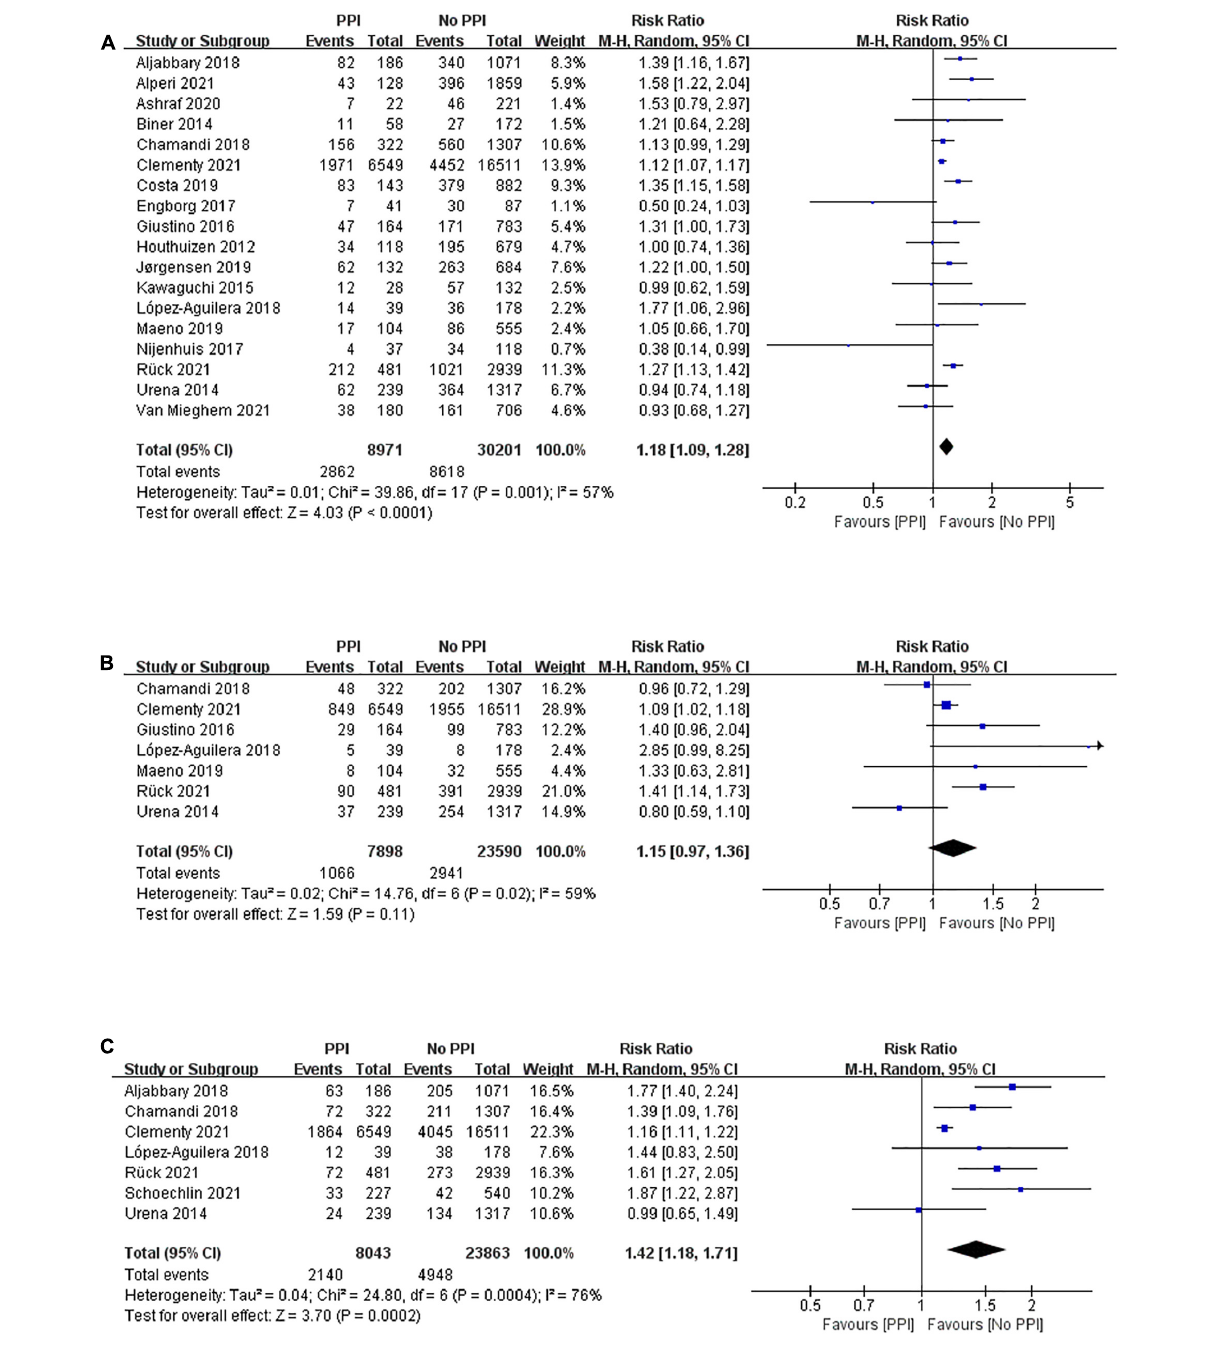
FIGURE 3 | Forest plot of the risk of long-term ( > 1 year) (A) all-cause mortality, (B) cardiovascular mortality, and (C) heart failure rehospitalization in patients with post-procedural PPI after